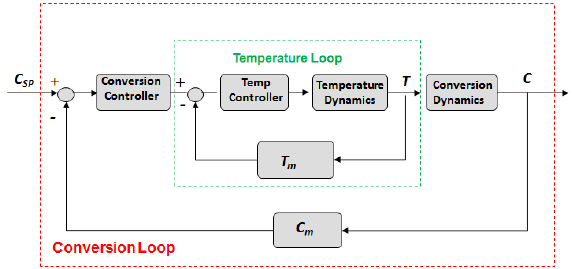
Figure 13. Schematic of cascade control for conversion.